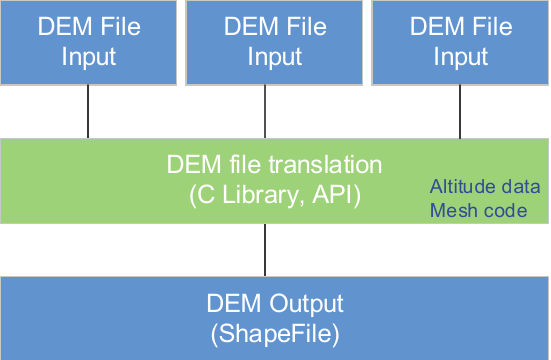
Figure 3. DEM file